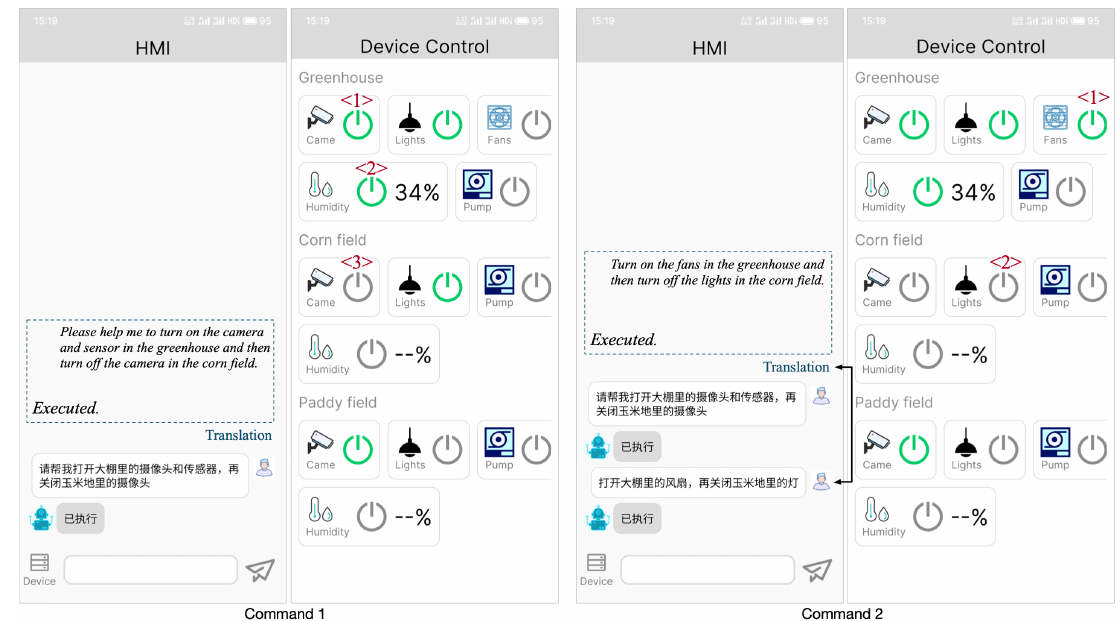
Figure 14. Mobile platform human–machine interaction interface in